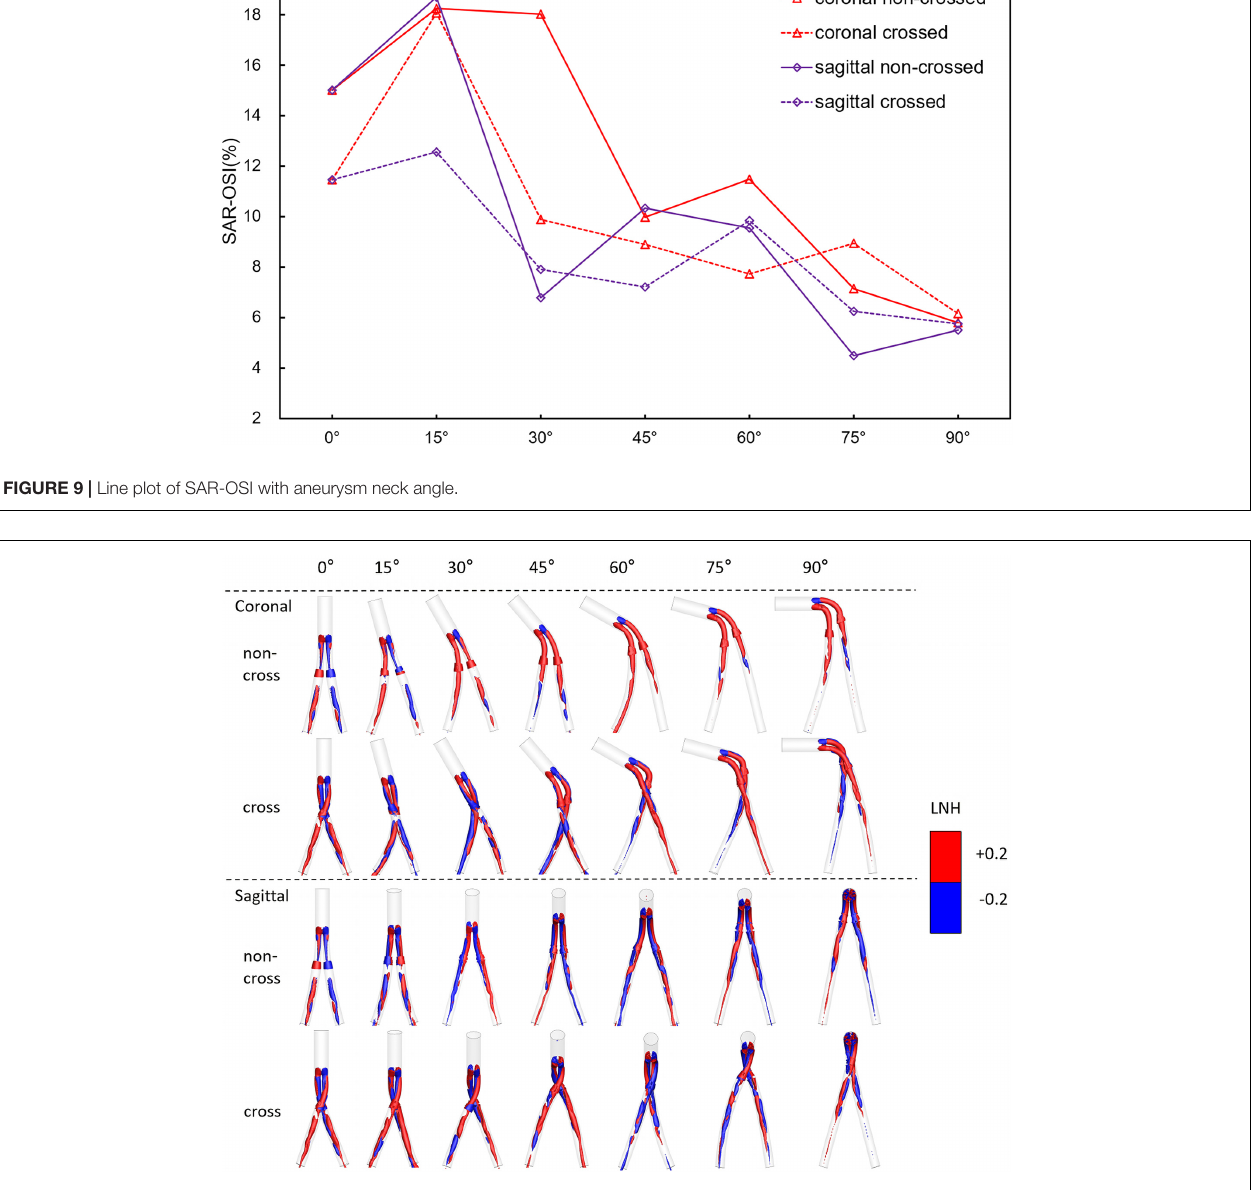
FIGURE 10 | Visualization of intravascular LNH iso-surfaces.